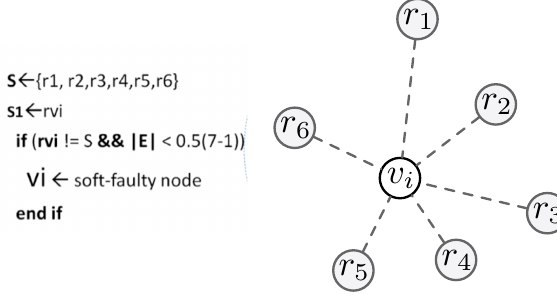
Figure 5. Fault detection process.